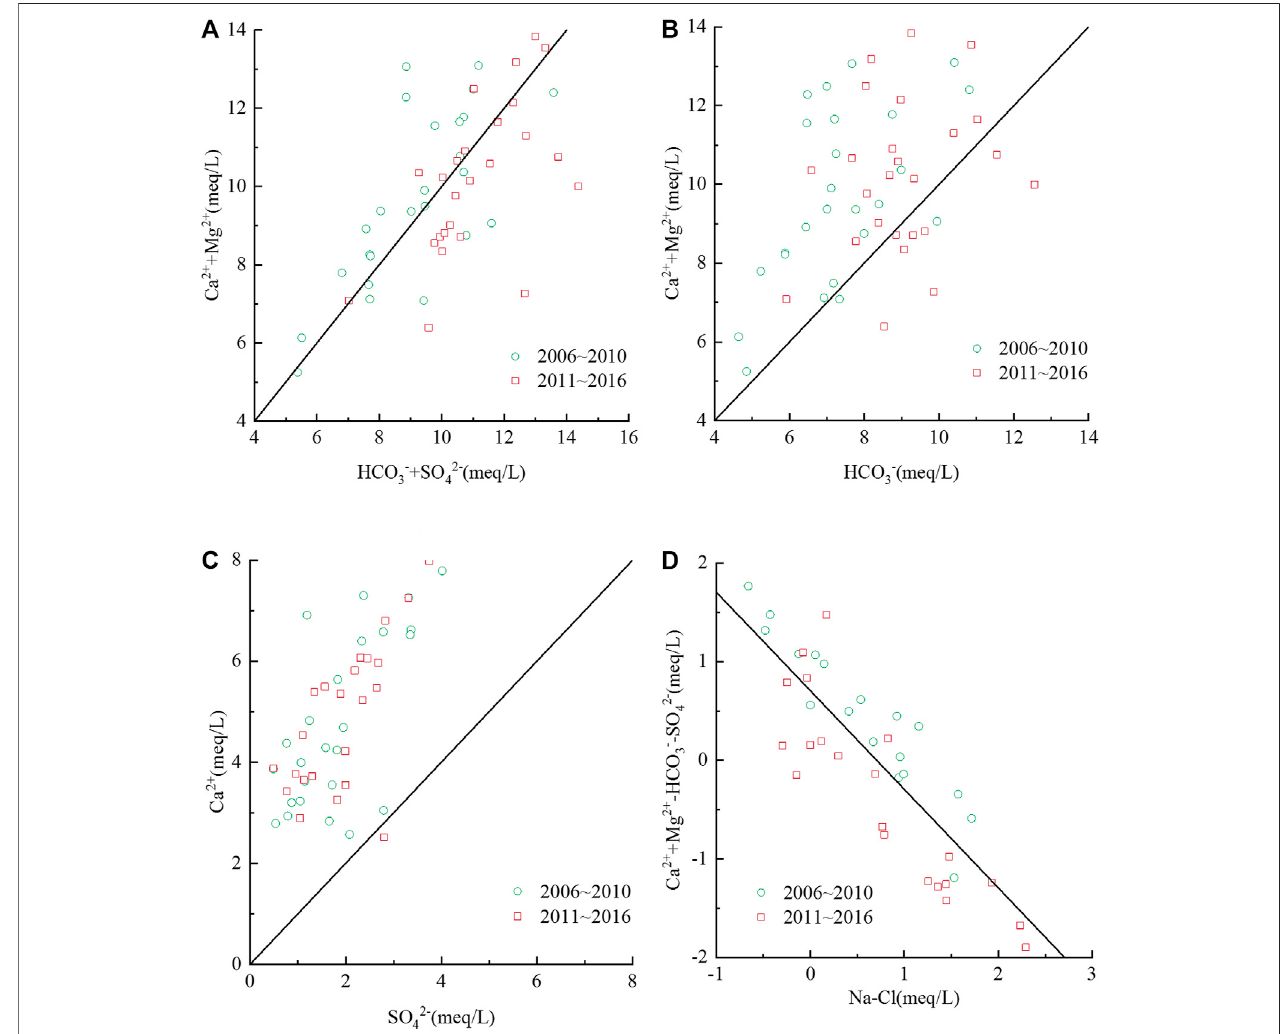
FIGURE 6 | Ratio diagram of the ions in the water chemical components in the study area.